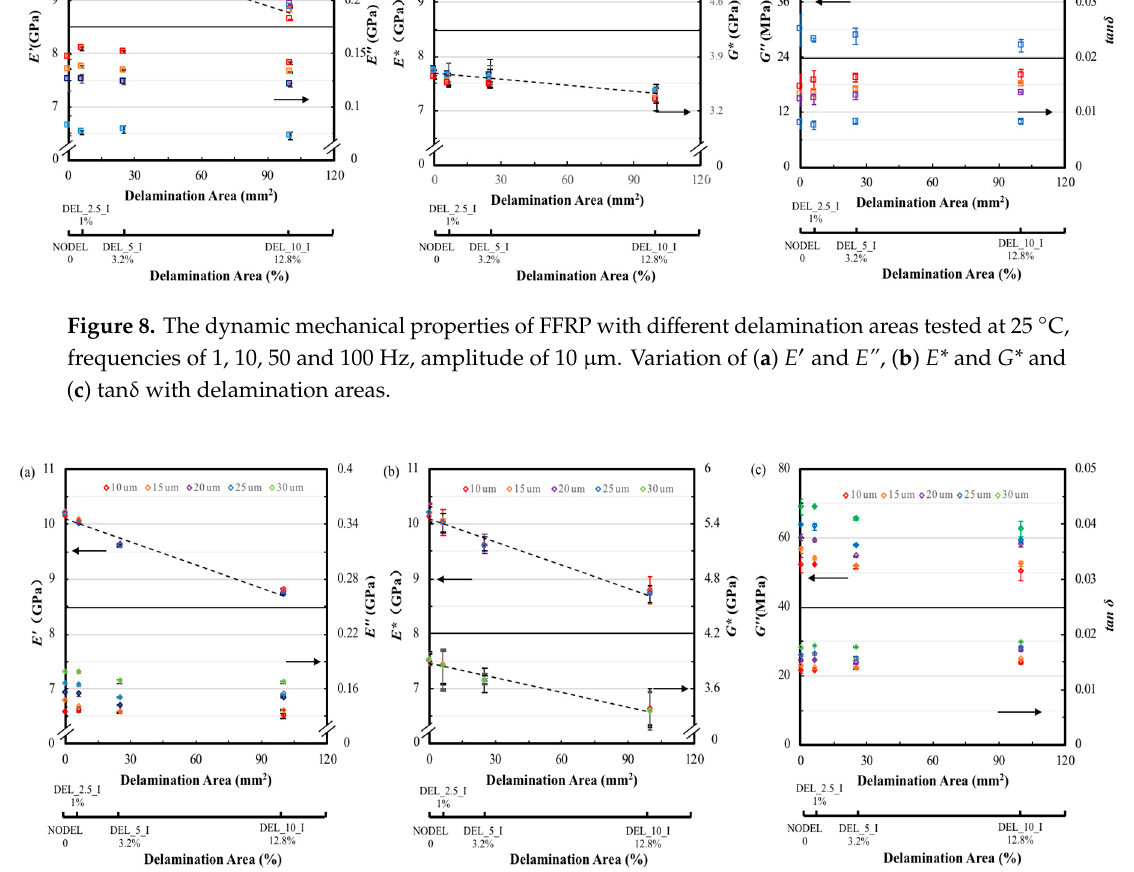
Figure 9. The dynamic mechanical properties of FFRP with different delamination areas tested at 25 °C, frequencies of 10 Hz, amplitude of 10, 15, 20, 25 and 30 µm. Variation of ( a ) E’ and E’’ , ( b ) E* and G* and ( c ) tan δ with delamination areas.